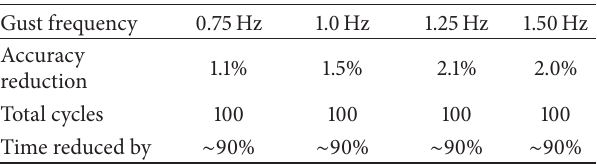
Table 3: Accuracy and computation time saving of the Q-static method in different gust